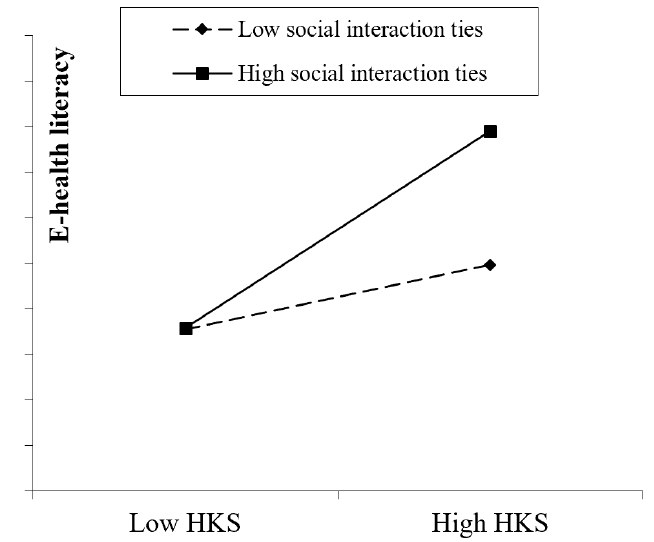
Figure 2. SIT positively moderating the effect of HKS on e-health literacy.